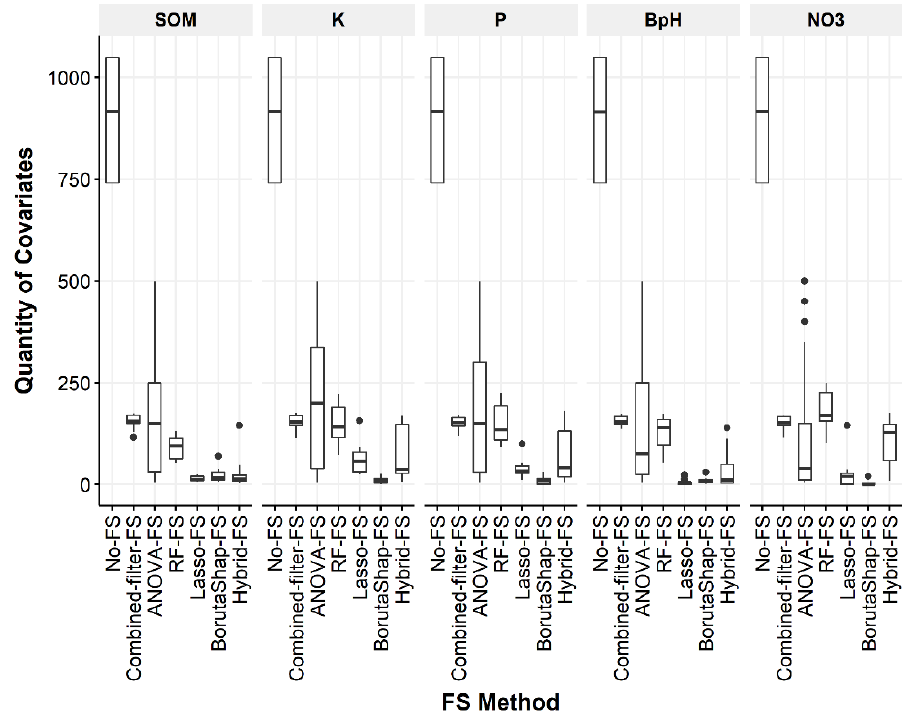
Figure 3. Quantities of covariates that each FS method selected per soil property. The variability shown was from differences in the quantity of covariates selected for different sample sets, including the sample set of all fields combined.